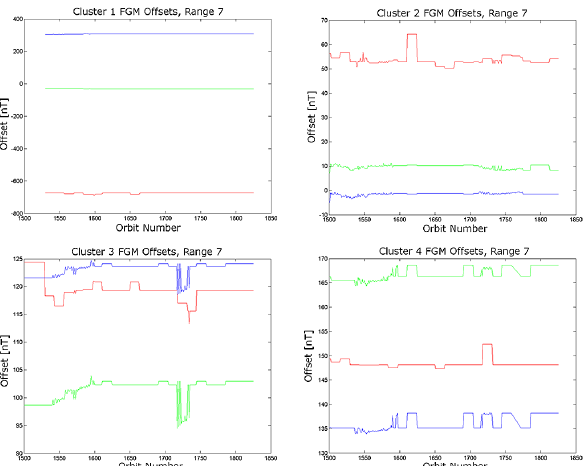
Figure 9. Range 7 spin-axis ( O 1 , red) and spin-plane ( O 2 and O 3 , blue and green) offsets in nanoteslas for orbits 1445–1825 (Decem- ber 2009–February